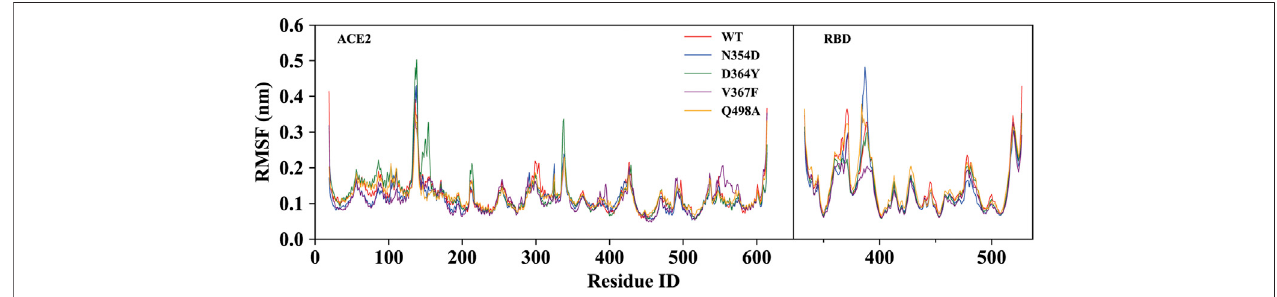
FIGURE 3 | RMSF of backbone atoms relative to the initial structure during the MD trajectories. RMSF values of ACE2 and RBD in the WT system (red), N354D system (blue), D364Y system (green), V367F system (blue) and Q498A system